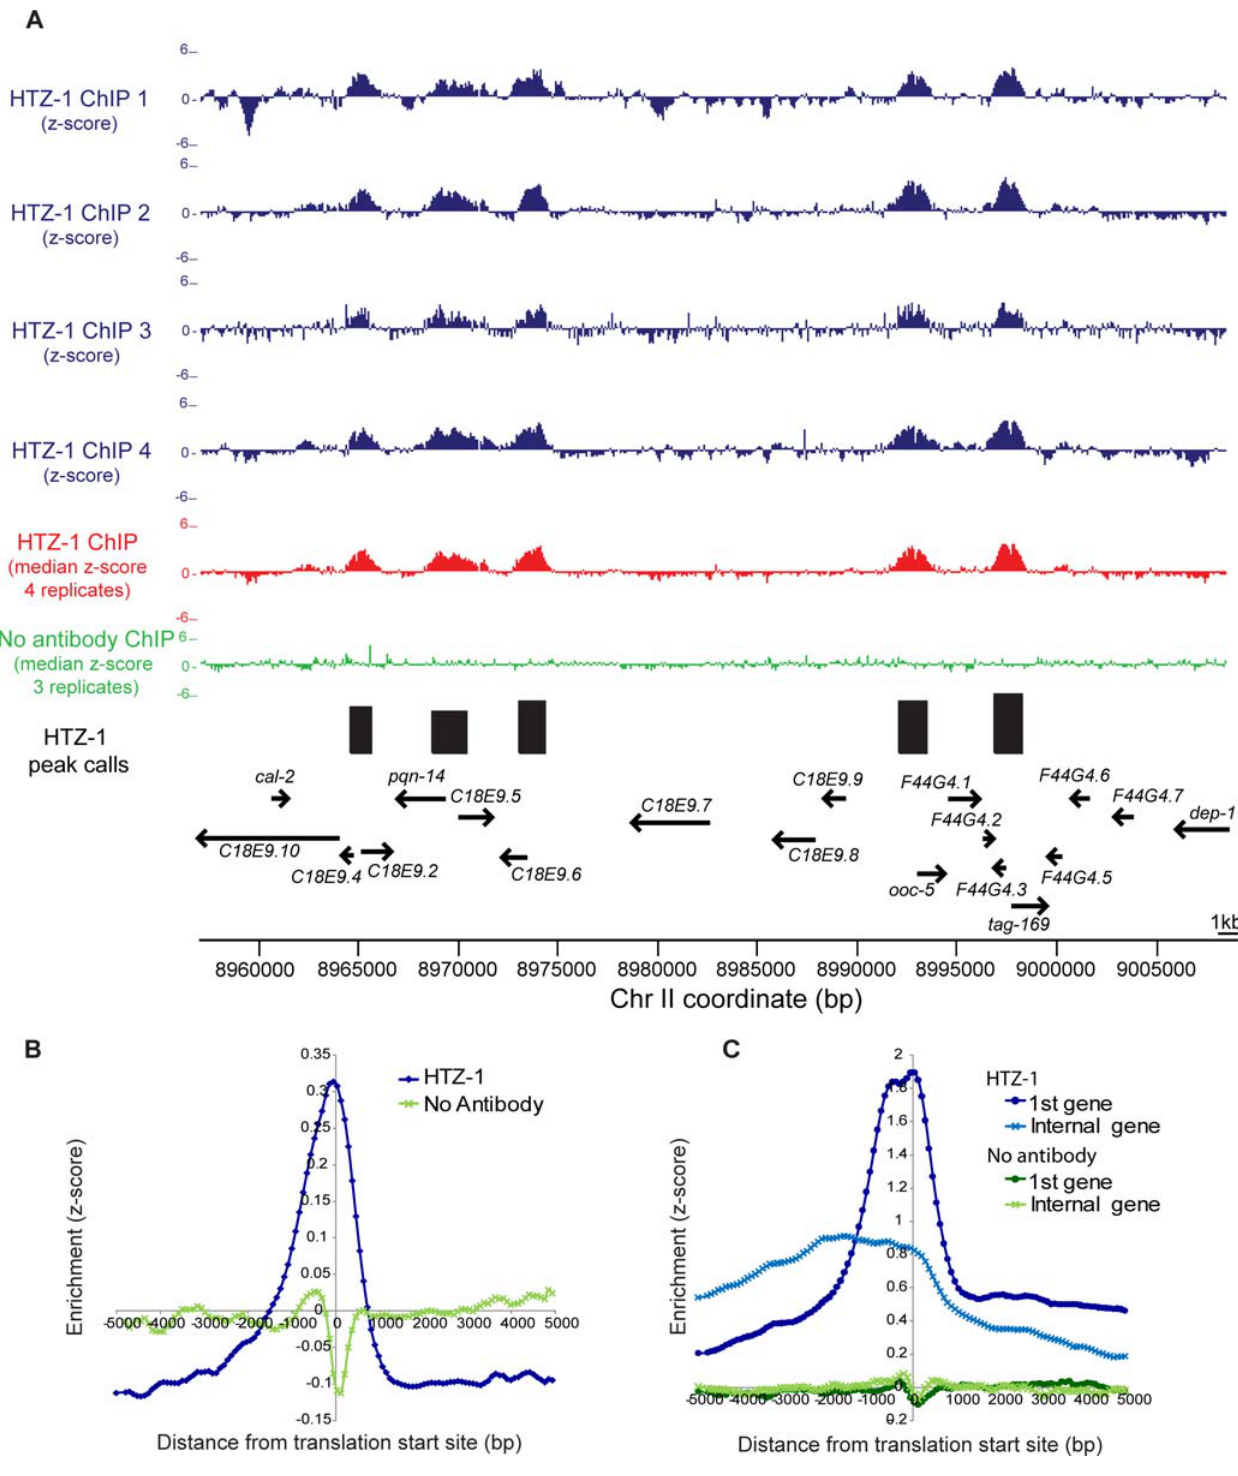
Figure 3. HTZ-1 localizes to sites of transcription initiation throughout the genome. (A). z-scores (calculated from the log 2 ratio (ChIP/ Input)) for each of the four HTZ-1 ChIPs (blue), the median HTZ-1 ChIP z-scores (red), and median no antibody ChIP (3 experiments; green) are plotted for 50 kb of chromosome II. Peaks of HTZ-1 binding are indicated by black bars, with gene annotations indicated below. Arrows specify the direction of transcription. (B) All genes were centered on the translation start site and HTZ-1 binding was averaged over all genes using a sliding window (window=3 probes, step=1 probe). A no antibody control ChIP is shown for comparison. The low-amplitude dip at the TSS in the no-antibody ChIP experiments is typical and has been reported previously [80] (C) Same as B, but for genes within operons.